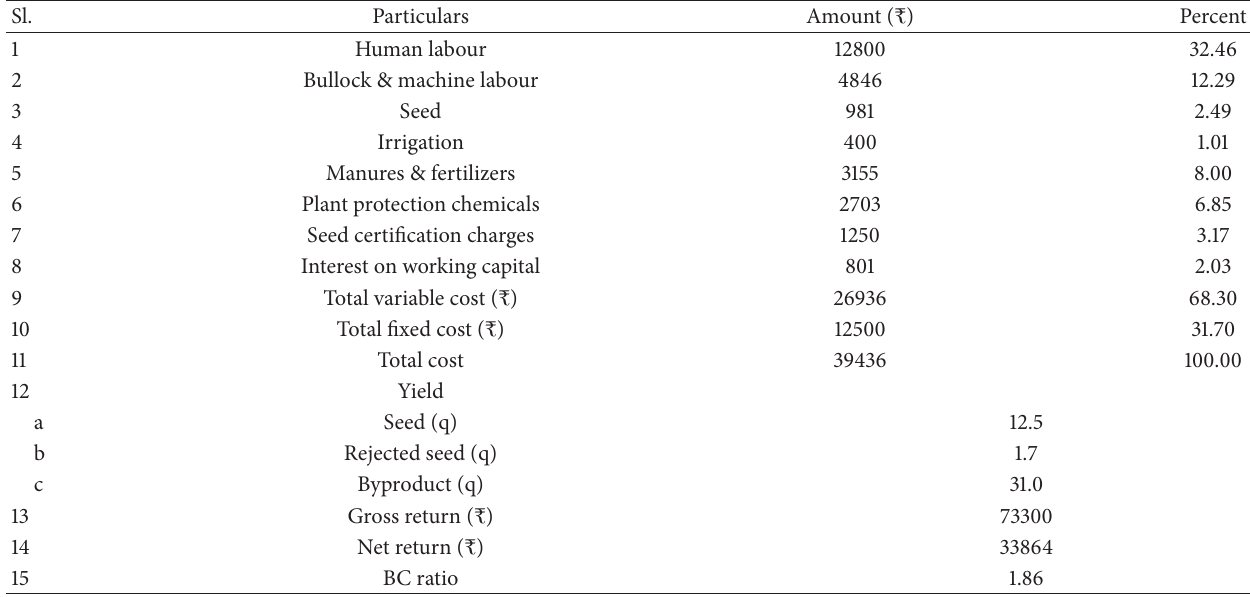
Table 5: Factors constraining adoption of pigeonpea seed produc- tion technology.